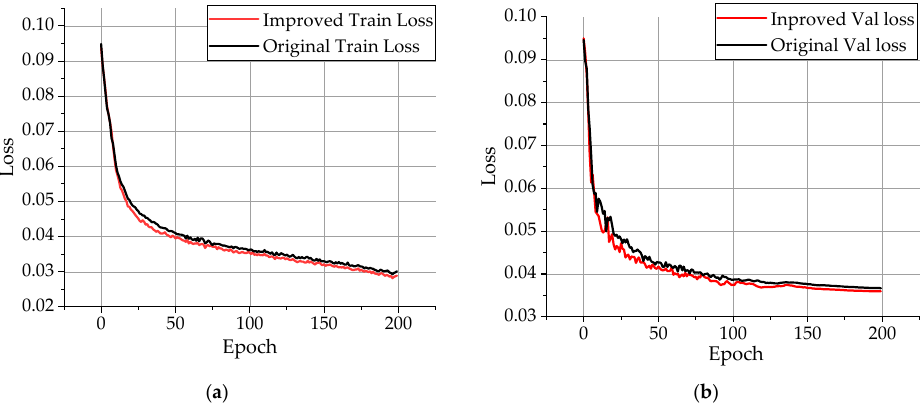
Figure 11. Loss function graph.( a )Train loss ; ( b )Val loss.